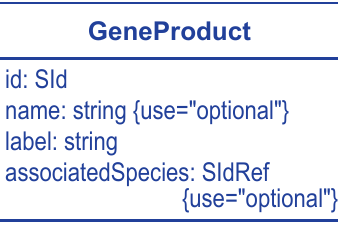
Figure 4: A UML representation of the Flux Balance Constraints package GeneProduct class. For a complete description see Figure 1 as well as Section 1.4 for conventions related to this figure.